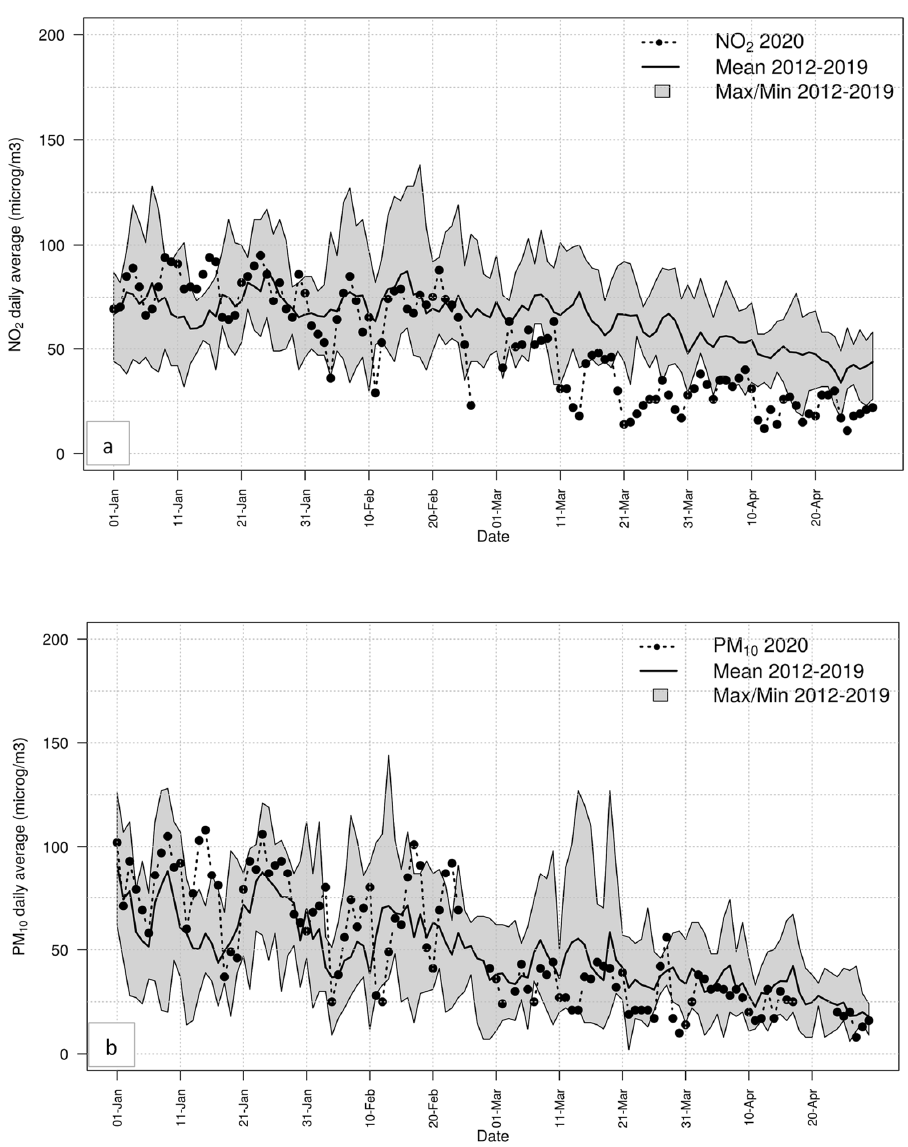
Figure 7. ( a ) NO 2 concentrations and ( b ) PM 10 concentrations measured, respectively, at Torino- Consolata (urban-traffic) and Torino-Lingotto (urban-background) station during COVID-19 lock- down of March and April 2020, compared to historical data (measurements from 2012 to 2019).